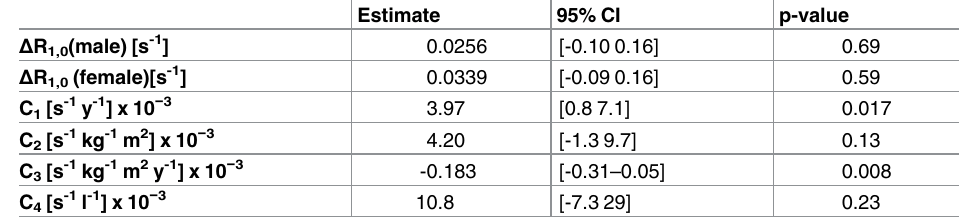
Table 3. Model parameters of Δ R 1 = Δ R 1 (sex) + C 1 Age + C 2 BMI + C 3 Age x BMI + C 4 Δ V L for n = 30, with 95% confidence intervals.